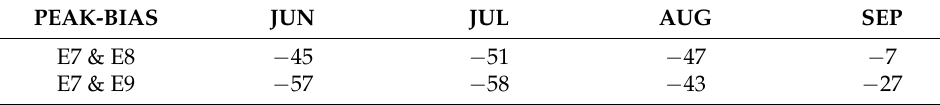
Figure 12. Multi peak rainfall patterns analysis. Table 9. PEAK BIAS for E7, E8, and E9.